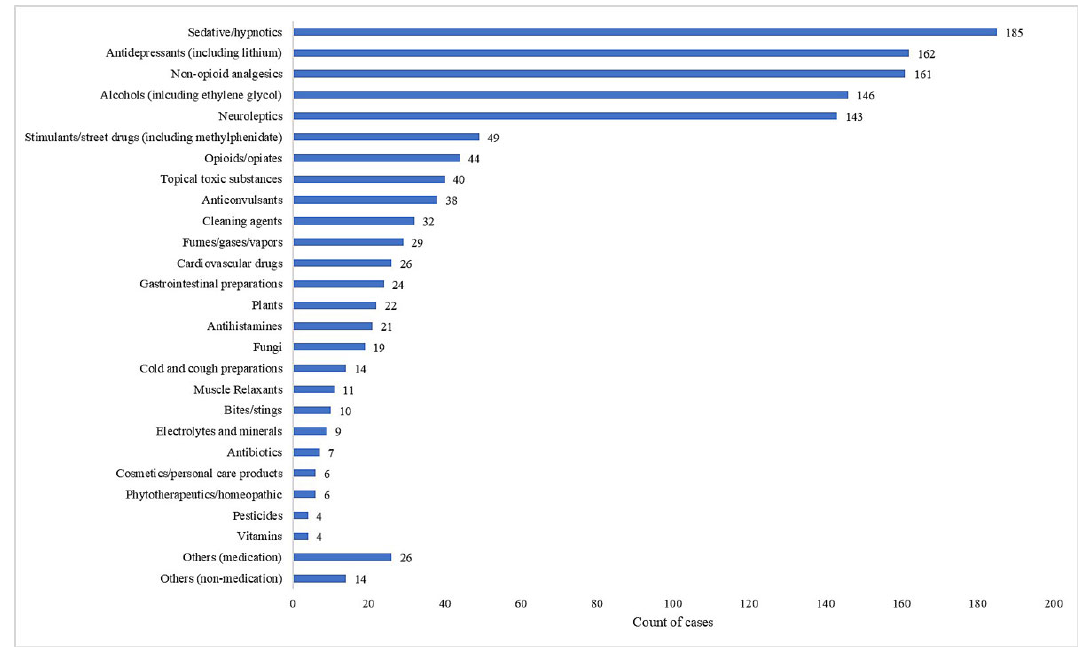
Figure 2: Involved agents/substances by number of cases (more than one agent involved in some cases).